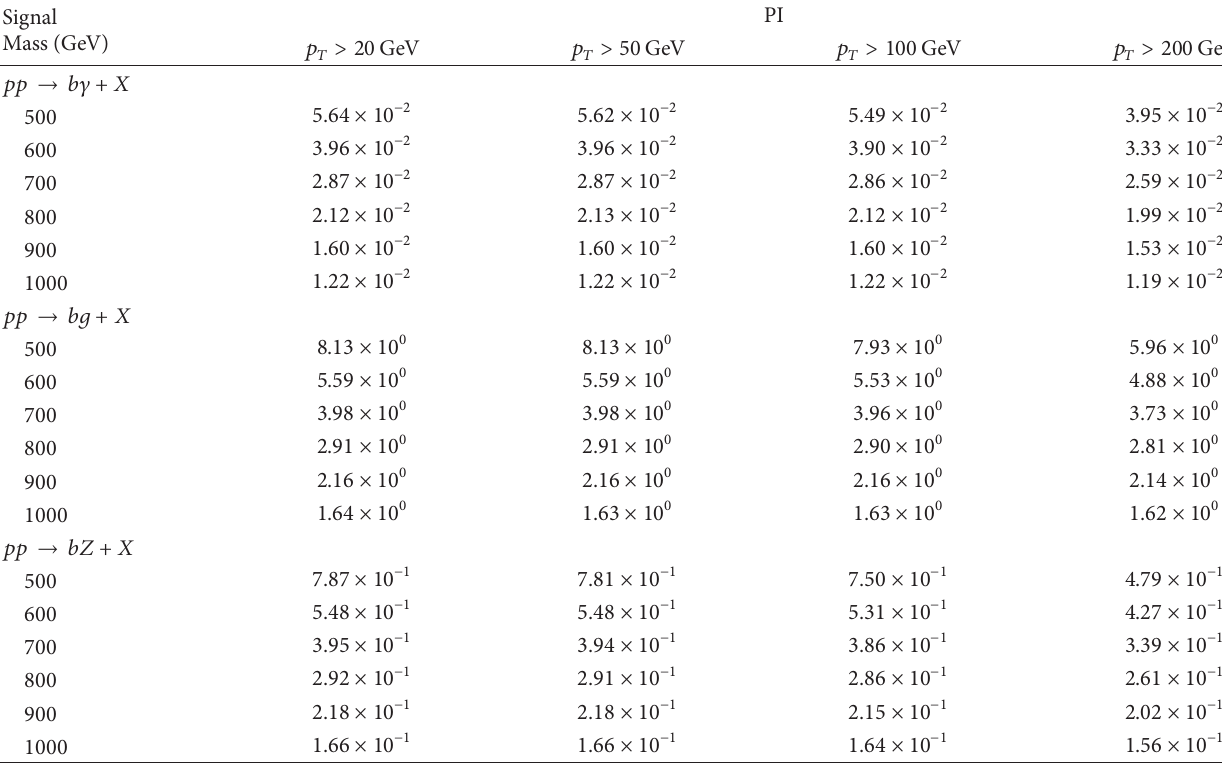
Table 11: The cross sections (in pb) for 𝑏 󸀠 signal in different decay channel for parametrization PI with 𝑝 𝑇 cuts on the jets and photon and | < 2.5 at the center of mass energy √𝑠 = 13 TeV. |𝜂 𝑗,𝛾